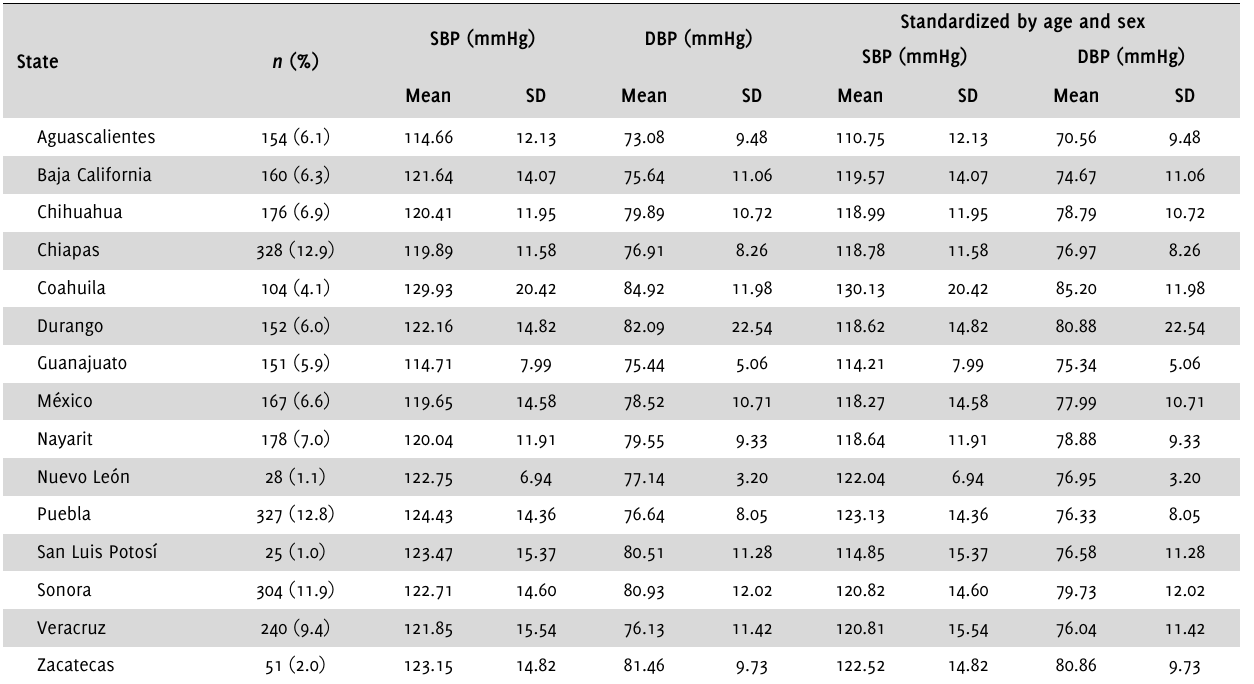
Table 2 . Mean Blood Pressure by State, before and after standardization by age and sex.